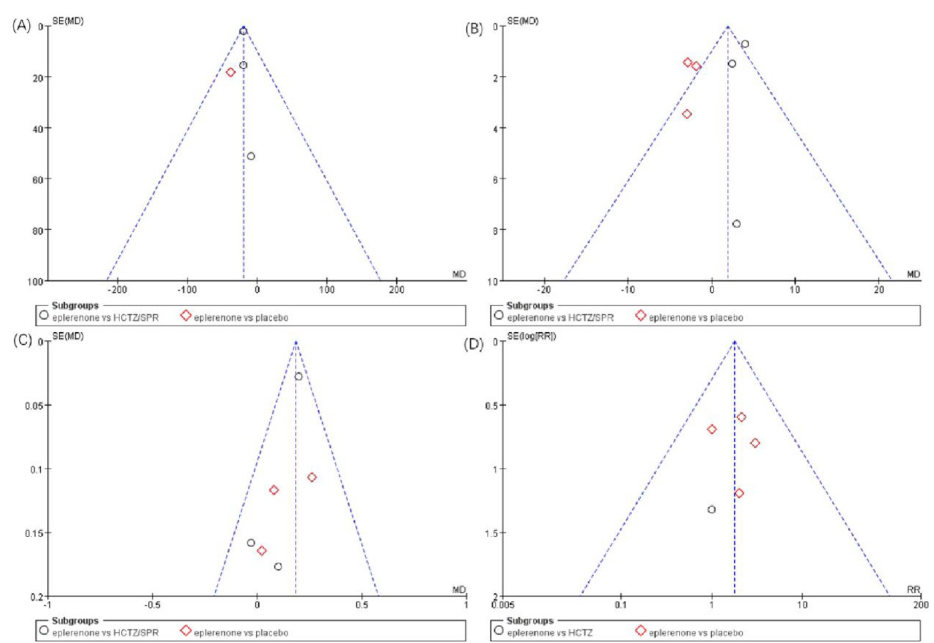
Fig 8. Funnel plots. Funnel plots of the effects of eplerenone treatment on (A) 24-h proteinuria (B) systolic pressure (C) potassium levels (D) adverse events of hyperkalemia at the end of follow-up.